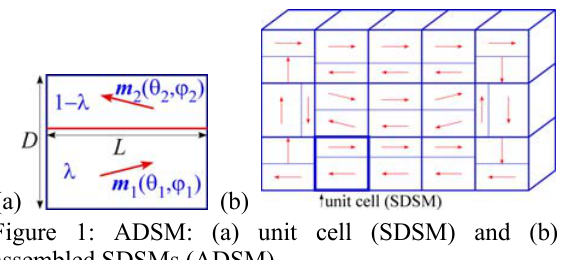
Figure 1: ADSM: (a) unit cell (SDSM) and (b) assembled SDSMs